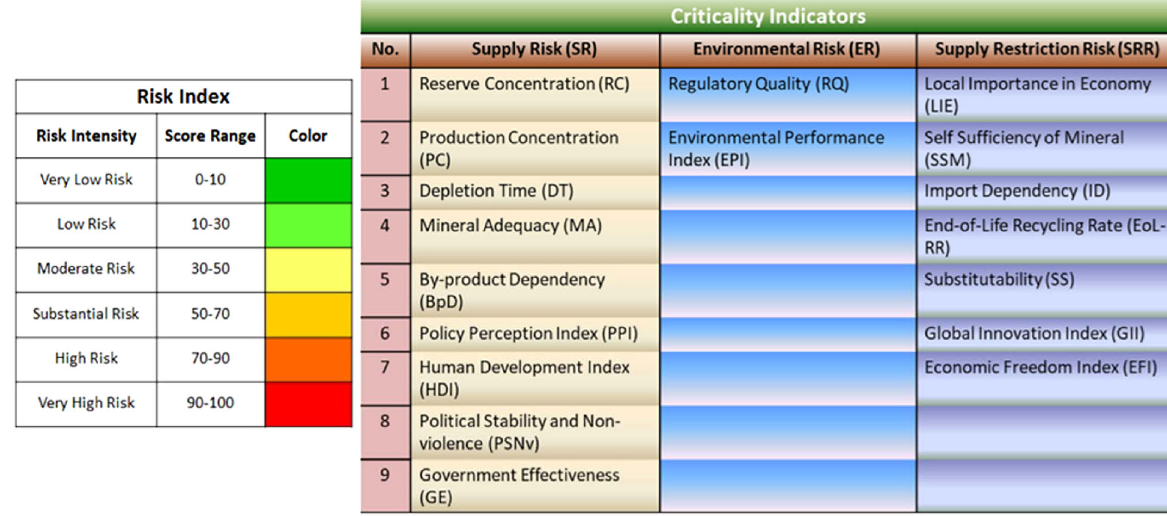
Fig. 2 A summary of the risk index and criticality indicators in the study. The indicators to measure SR, ER, and SRR are proposed not only conducting a comprehensive investigation of previously published papers but novel indicators are also introduced to develop the methodology. The risk score determination routes of each indicator are prudently described in the Supplementary